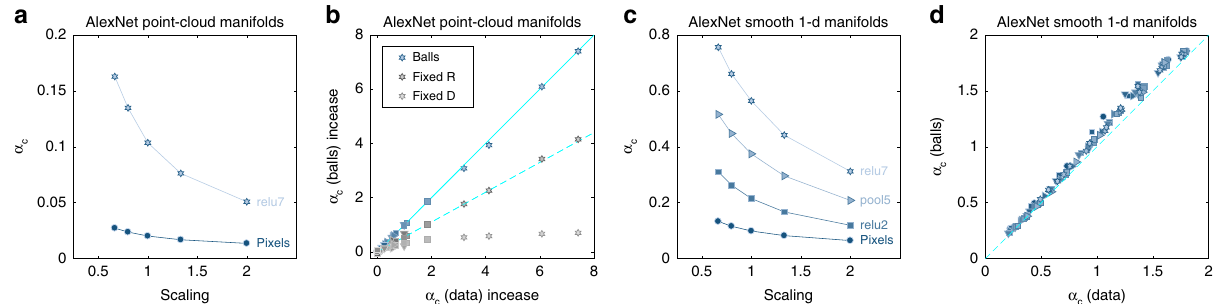
Fig. 10 Manifold structure perturbations effect on capacity. a Classi fi cation capacity following manifold scaling ( x -axis indicate scaling factor, with 1 corresponds to no scaling) for AlexNet at different layers along the hierarchy (top 10% point-cloud manifolds). b Comparison of classi fi cation capacity ( x - axis) with the prediction from balls with the same manifold properties ( y -axis) for AlexNet at different layers along the hierarchy (point-clouds of top 10% and full class manifolds). As capacity of those manifolds spans two orders of magnitude it is normalized by capacity at the pixel layer. The full cyan line indicate y = x while the dashed cyan line indicate y = 0.55 x . c Classi fi cation capacity following manifold scaling ( x -axis indicate scaling factor, with 1 corresponds to no scaling) for AlexNet at different layers along the hierarchy (smooth 1-d translation manifolds). d Comparison of numerically measured capacity ( x -axis) with numerically measured capacity of balls with the same manifold properties ( y -axis) for AlexNet at different layers along the hierarchy and different levels of manifold variability (smooth 1-d translation manifolds). The dashed cyan line indicate y = x . Marker shape represents layer type (circle — pixel layer, square — convolution layer, right-triangle — max-pooling layer, hexagon — fully connected layer, down-triangle — local normalization layer). Color changes from dark to light along the